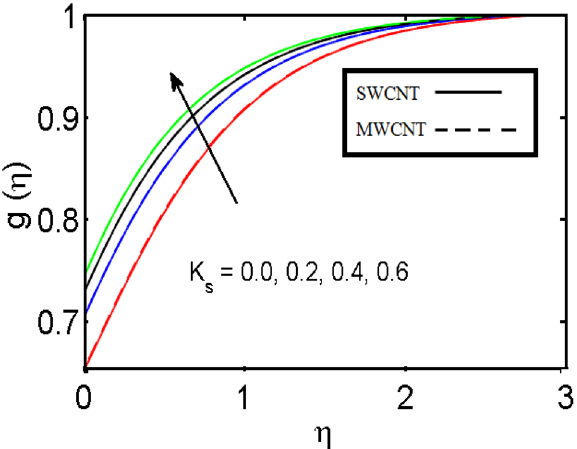
Figure 5. Illustration of concentration profile g (η) for different values of K s .